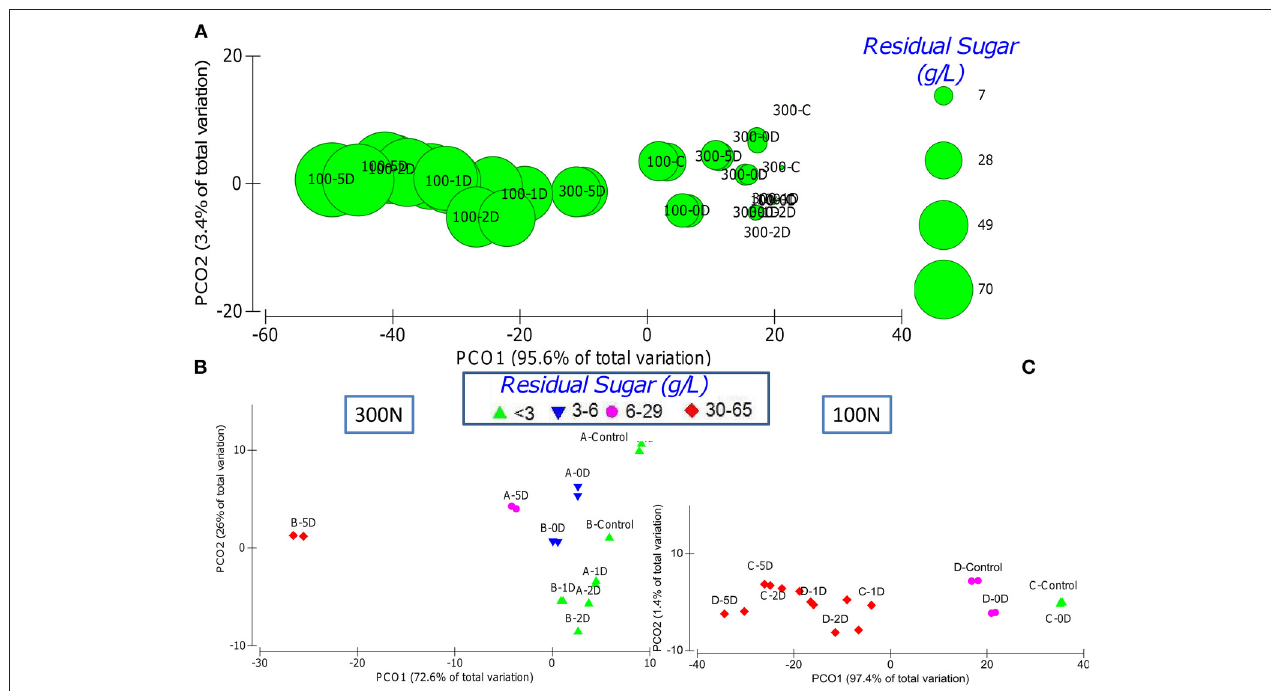
FIGURE 2 | PCA graphs displaying the dissimilarity between the different fermentations taking into account the kinetics parameters R, t10, t50, t75, acetic acid and residual sugar. (A) PCA representing all the fermentations respects the residual sugar content (proportional to the bubbles size) with the clustering of most of 100N fermentations at the left and most of the 300N fermentations at the right. PCA of the 300N (B) and 100N (C) fermentations respect the residual sugar where the initial sugar concentration is indicated by A or C (200S) and B or D (240S), Control represent the inoculations with only S. cerevisiae and the inoculation time of S. cerevisiae is indicated by 0D, 1D, 2D, and